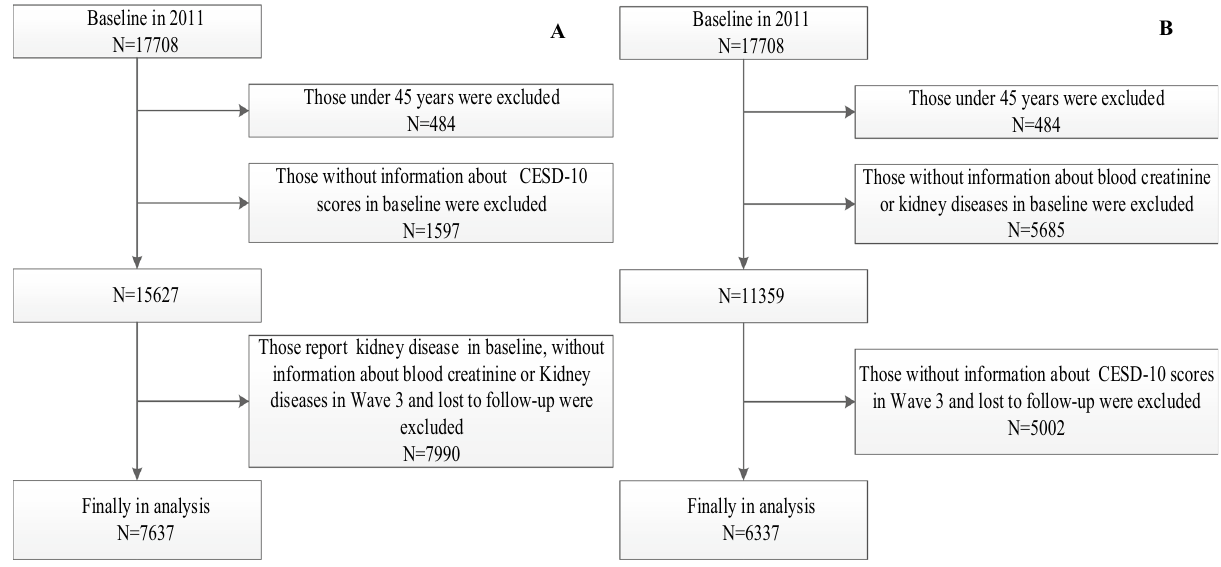
Figure 1. Flow chart of the selection of the study population for Study I ( A ) and Study II ( B